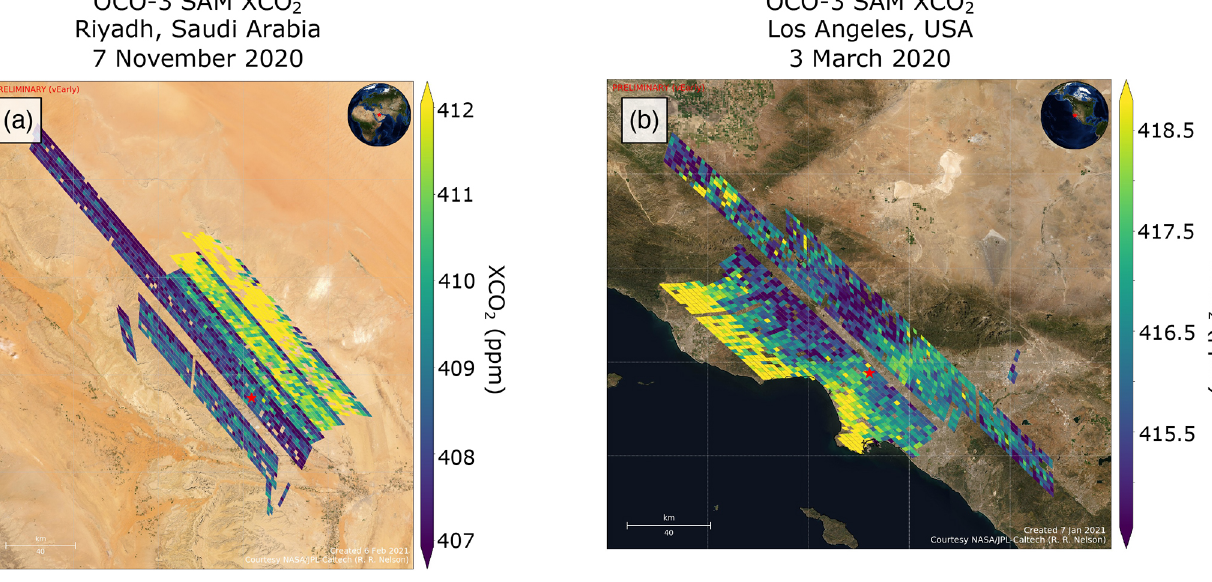
data product, over (a) Riyadh, 2